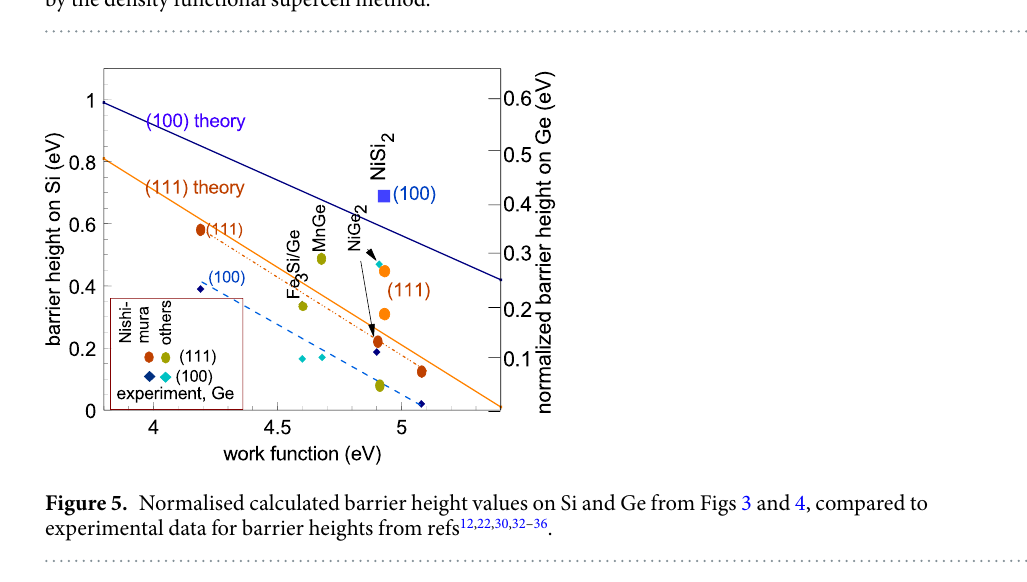
Figure 4. Calculated p-type Schottky barrier heights for Ge/metal germanides, for (111), and (100) interfaces, by the density functional supercell method.